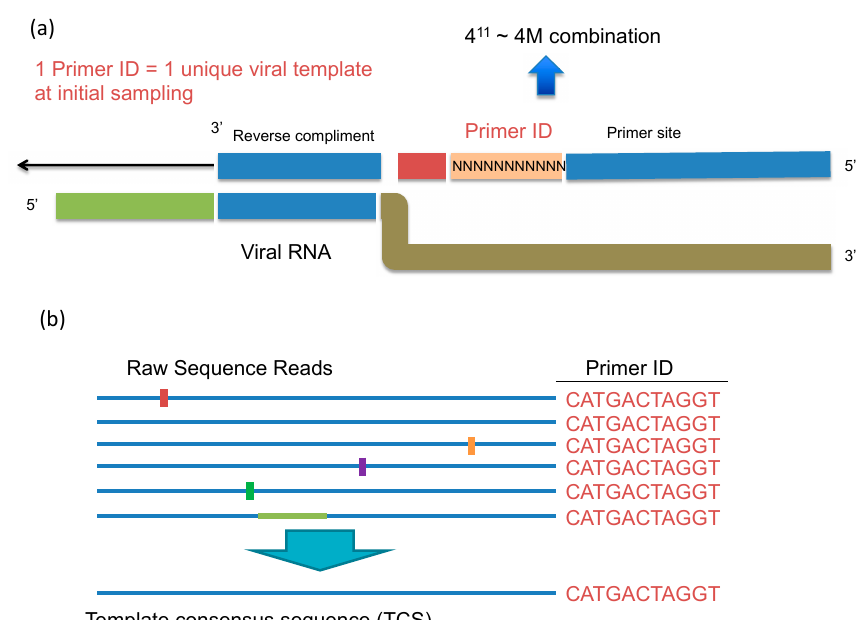
Figure 3. Illustration of Primer ID cDNA primer and how Primer ID reduces methods error ( a ) Primer ID cDNA primer. Ns in the Primer ID cDNA primer is a block of degenerate nucleotides. ( b ) Reads with same Primer ID will be collapsed to make a template consensus sequence based to greatly reduce errors. Colored vertical lines on the sequence reads indicate PCR mis-incorporations or sequencing errors, and the colored horizontal block indicates the PCR recombination.